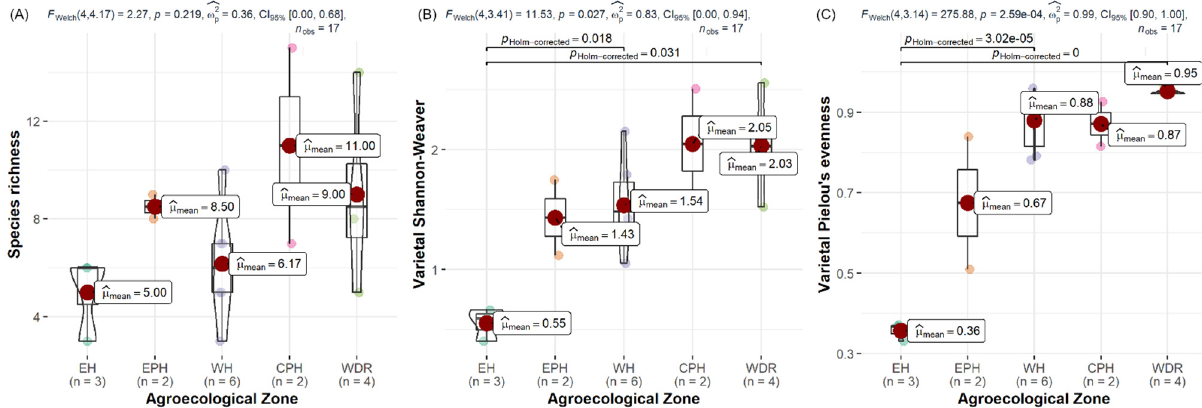
Figure 3. ( A ) Diversity indexes at the species (species richness); ( B )varietal level (Shannon–Weaver); ( C ) varietal level (Pielou’s). Abbreviations: EH, Eastern Himalayan; EPH, Eastern Plateau and Hills; WH, Western Himalayan; and CPH, Central Plateau and Hills; WDR: Western Dry Region. Significant pairwise comparisons of the Games–Howell test p ≤ 0.05 are displayed. Table 3. List of crops including the scientific name of cultivate species and the number of varieties identified in the study.